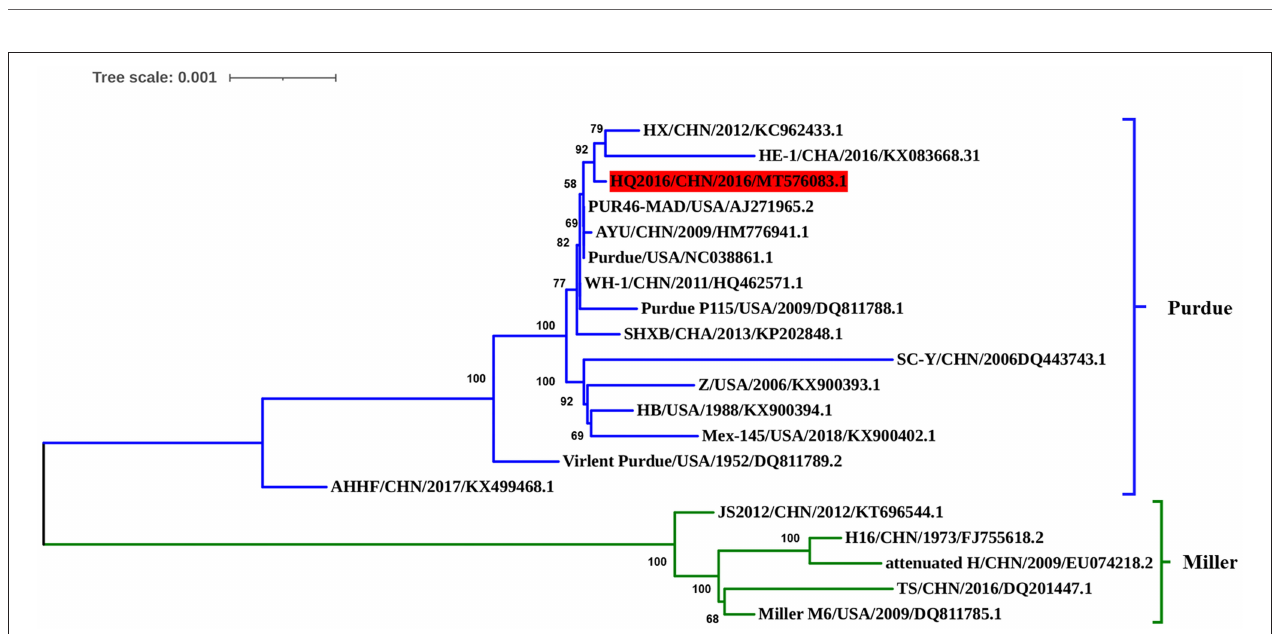
FIGURE 4 | Phylogenetic analysis of the complete genome sequences of the strain HQ2016, other TGEV reference strains. TGEV HQ2016 belongs to the Purdue cluster of TGEV, not the Miller cluster. Complete genome were aligned used Clustal W program which have trimed both 3 ′ and 5 ′ ends gaps between TGEV genomes Phylogenetic tree was constructed using the neighbor-joining method with the MEGA 6.0 program. The optimal tree with the sum of branch length = 0.02540989 is shown. The percentage of replicate trees in which the associated taxa clustered together in the bootstrap test (1,000 replicates) are shown next to the branches. The tree is drawn to scale, with branch lengths in the same units as those of the evolutionary distances used to infer the phylogenetic tree. The evolutionary distances were computed using the Tajima-Nei method.